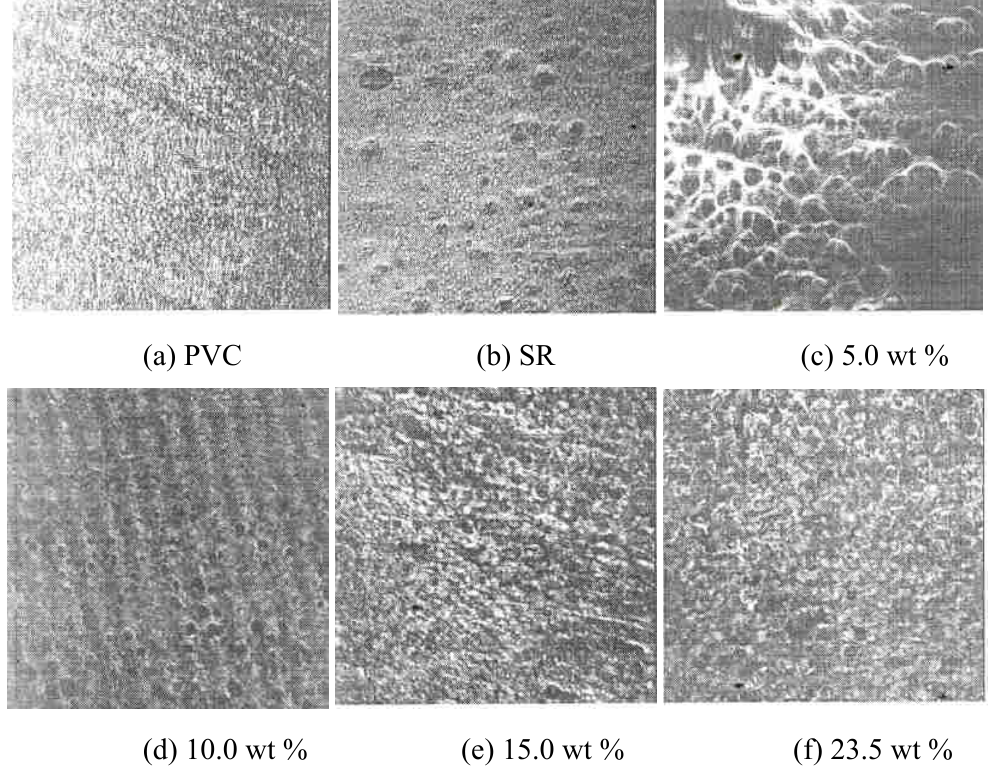
Figure 3 . BAM images of the membrane based on the PVC-SR coated on carbon